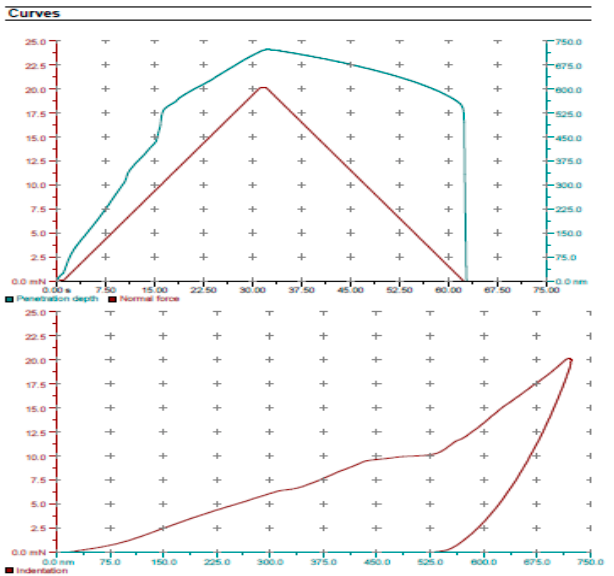
Figure 15. Quasi-uniform composite and dimensional nano-identation curves on coating (indentation depth in nm).